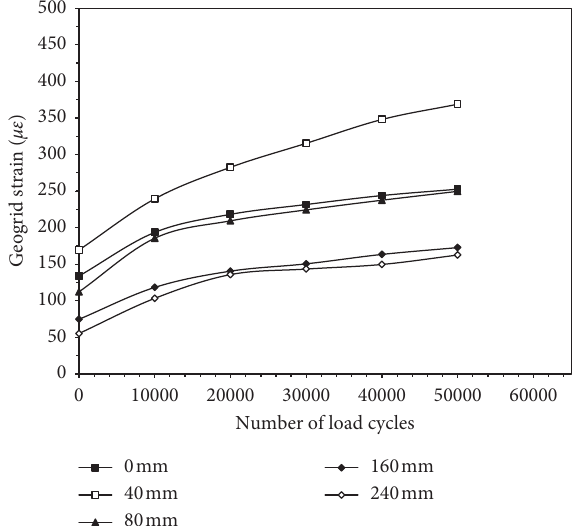
Figure 12: Geogrid strain-number of load cycles curves of the geogrid in RGF1 under cyclic